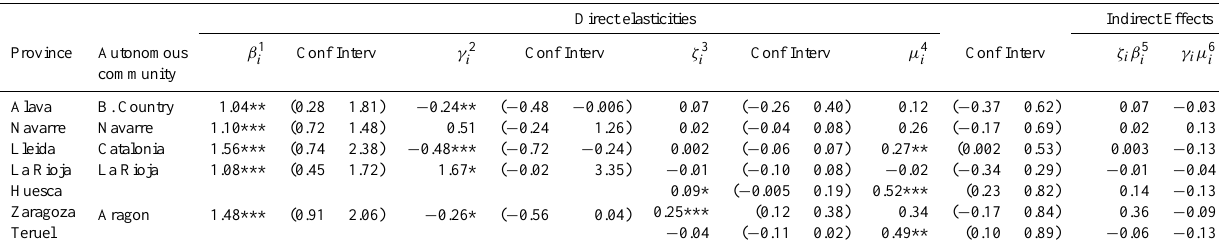
Table 4. Economic variables elasticity in relation to water availability. Direct elasticities Indirect